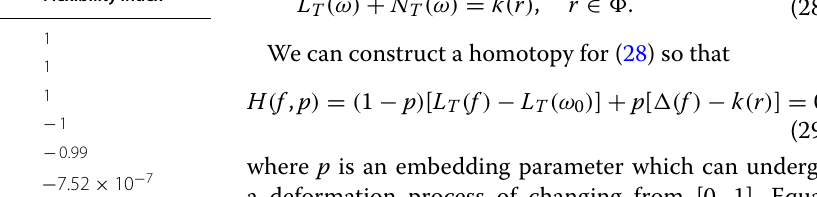
Table 3 Sensitivity indices of R 0 = 0.01409544898 to model’s parameters Parameter Flexibility